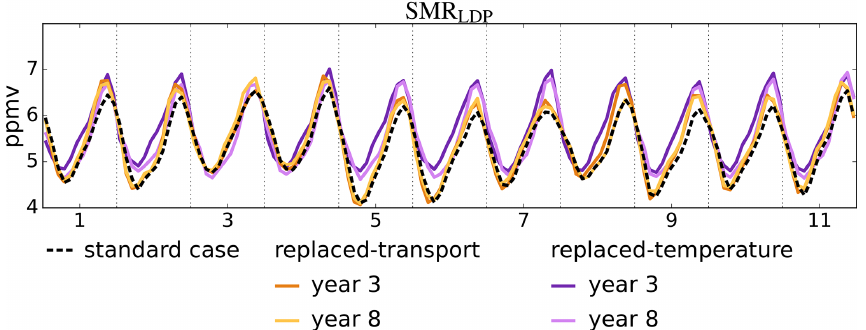
Figure 12. As for Fig. 2 but for the climate model. Time series of LDP calculations of water vapour entering the stratosphere for the standard case (black dotted line), replaced transport from 2 other years (orange lines) and replaced temperatures also from 2 other years (purple